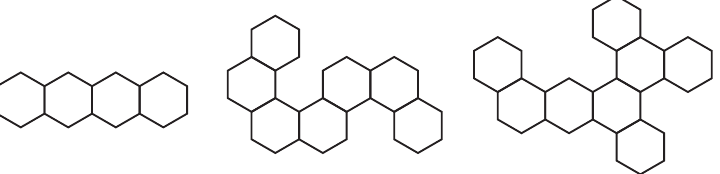
Figure 1. Catacondensed benzenoid